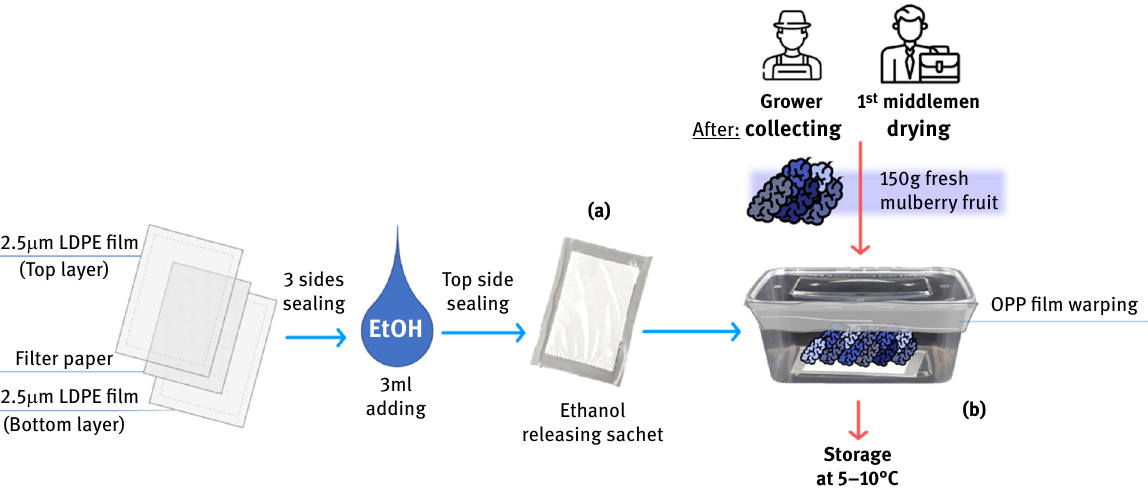
Figure 5: Component of the developed active packaging for mulberry fruit from the previous study [ 40 ] . Component of the fruits contained ethanol slow releasing sachet ( a ) and airtight container ( b )